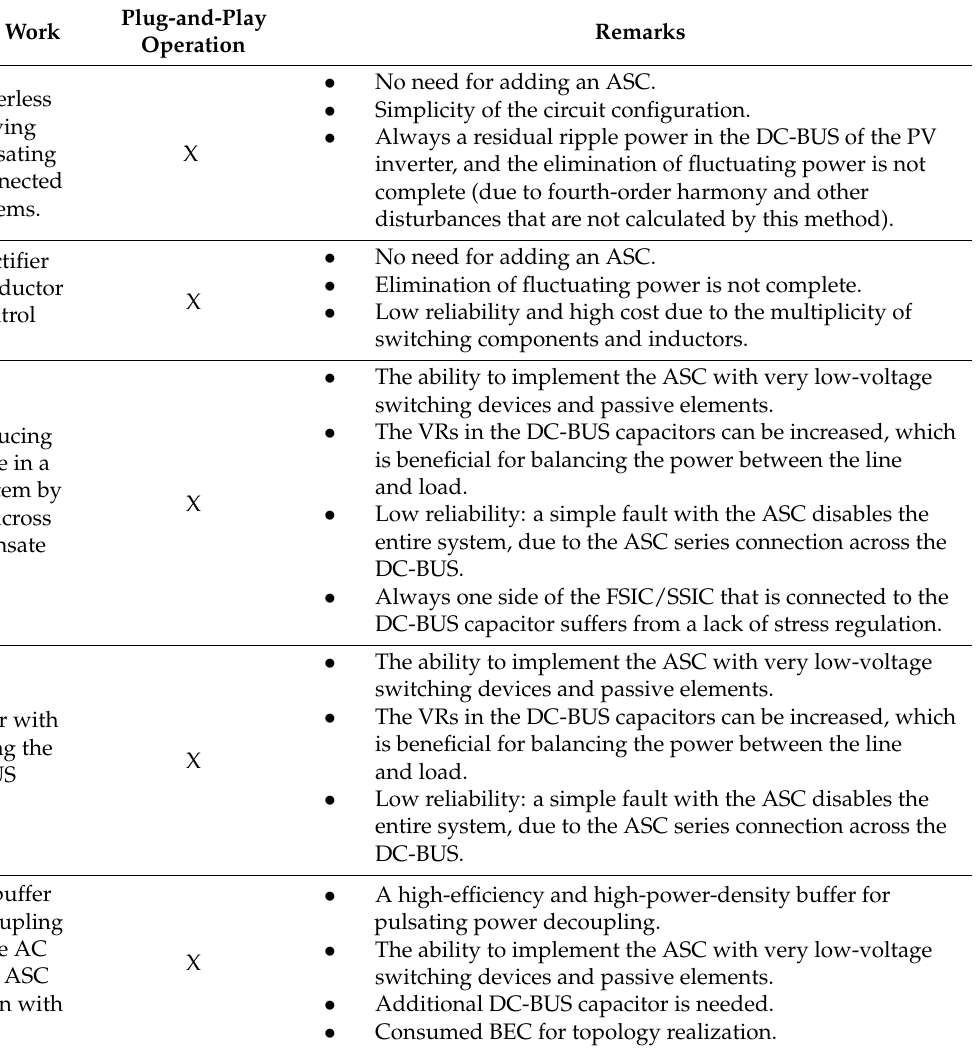
Table 3. Comparison of different topologies and control strategies. Authors, Year, and